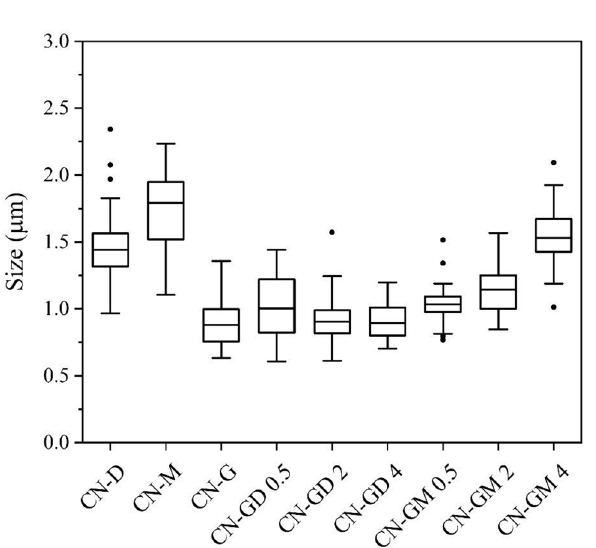
Figure 11. Micrographs (SEM:SE + BSE) of CN-GM 0.5 ( G1,G2 ), CN-GM 2 ( H1,H2 ) and CN-G 4 ( I1,I2 ).